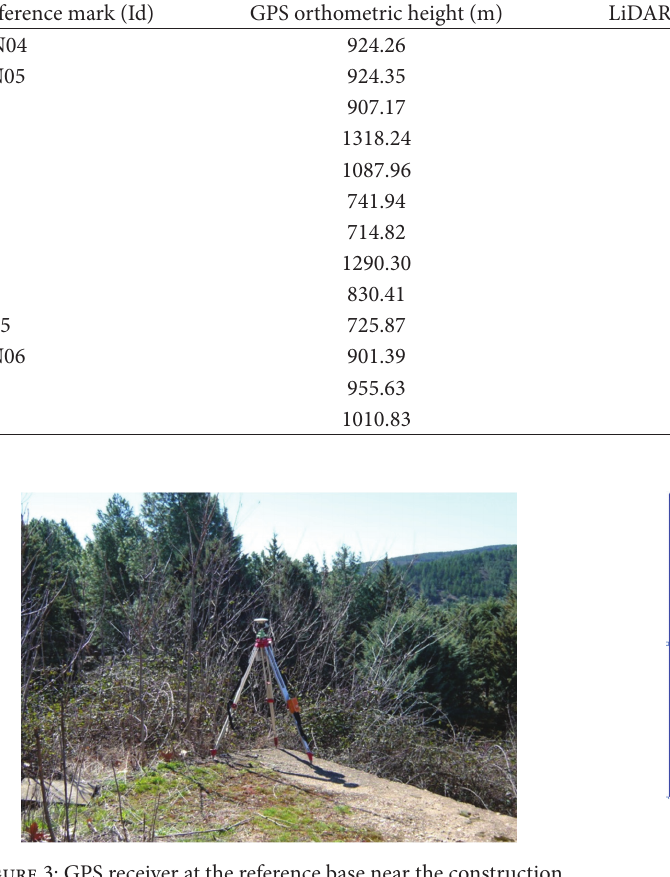
F 3: GPS receiver at the reference base near the